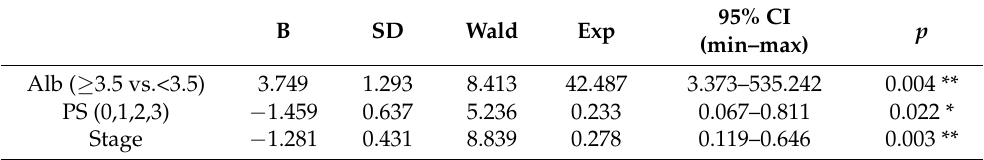
Figure 2. Kaplan–Meier survival curve according to the treatment group. Table 2. Logistic multivariate analysis for selecting surgery in elderly patients with